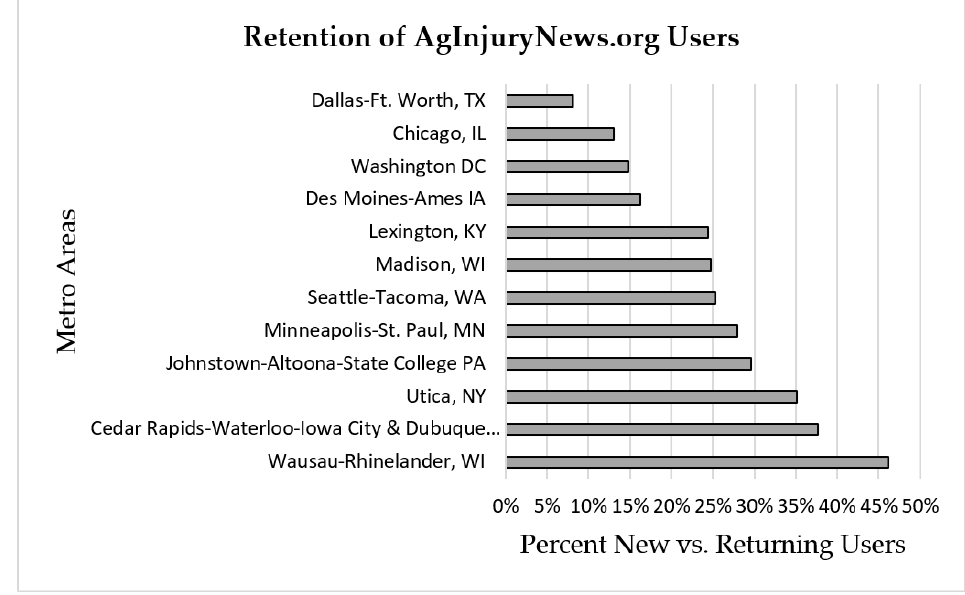
Figure 1. Retention of AgInjuryNews user by metro area. Table 3. User acquisition sources and behavior during site sessions.